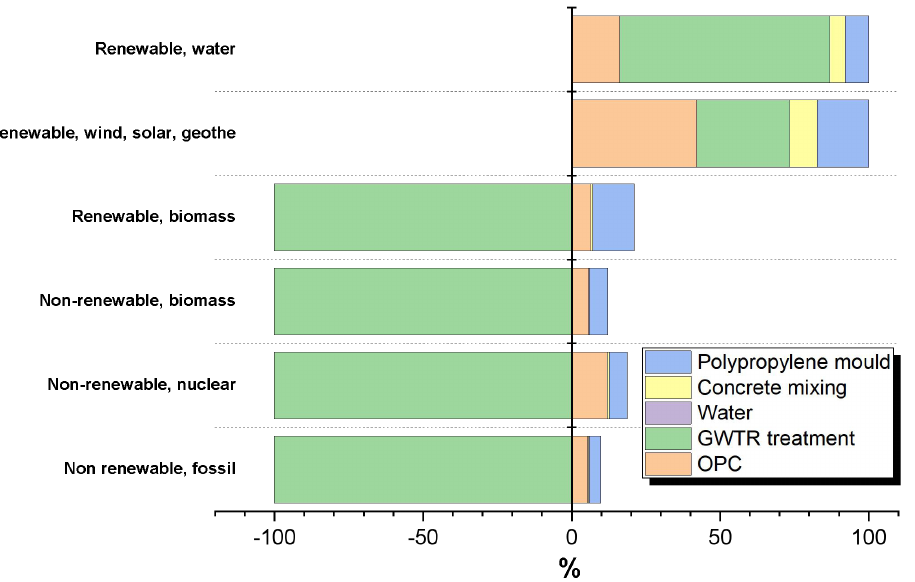
Figure 10. Graph of the CED contributions referred to in the production process of the c-RuC mix. The histograms refer to the contributions of non-renewable (fossil, nuclear, and biomass) and renewable (biomass, wind, solar, geothermal, and water) energy